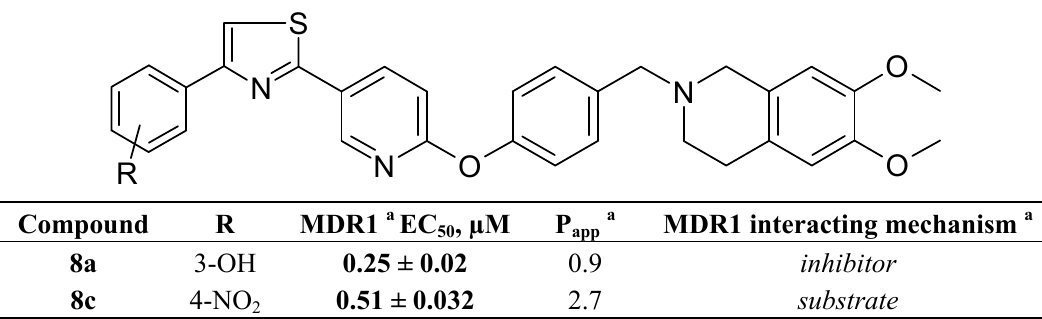
Table 1. Biological evaluation of tariquidar derivatives 8a and 8c .